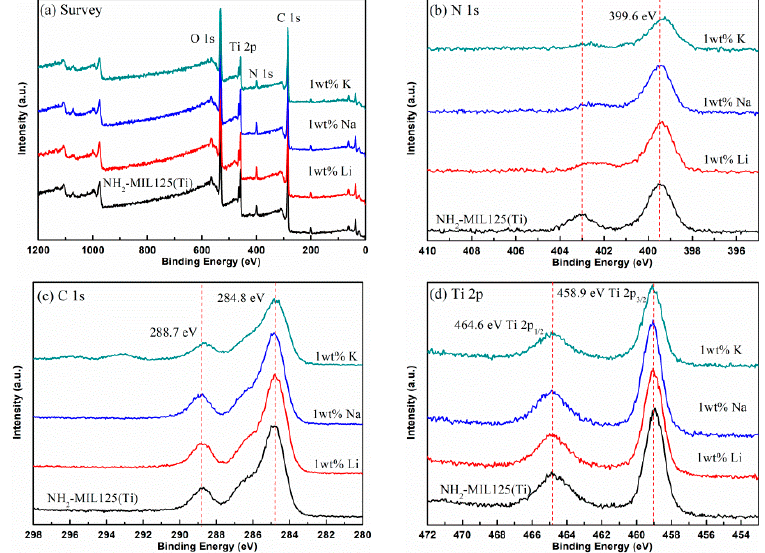
Figure 3. The X-ray photoelectron spectrometer (XPS) spectra of doped and pristine NH 2 –MIL125(Ti): ( a ) survey, ( b ) N 1s, ( c ) C 1s, ( d ) Ti 2p.